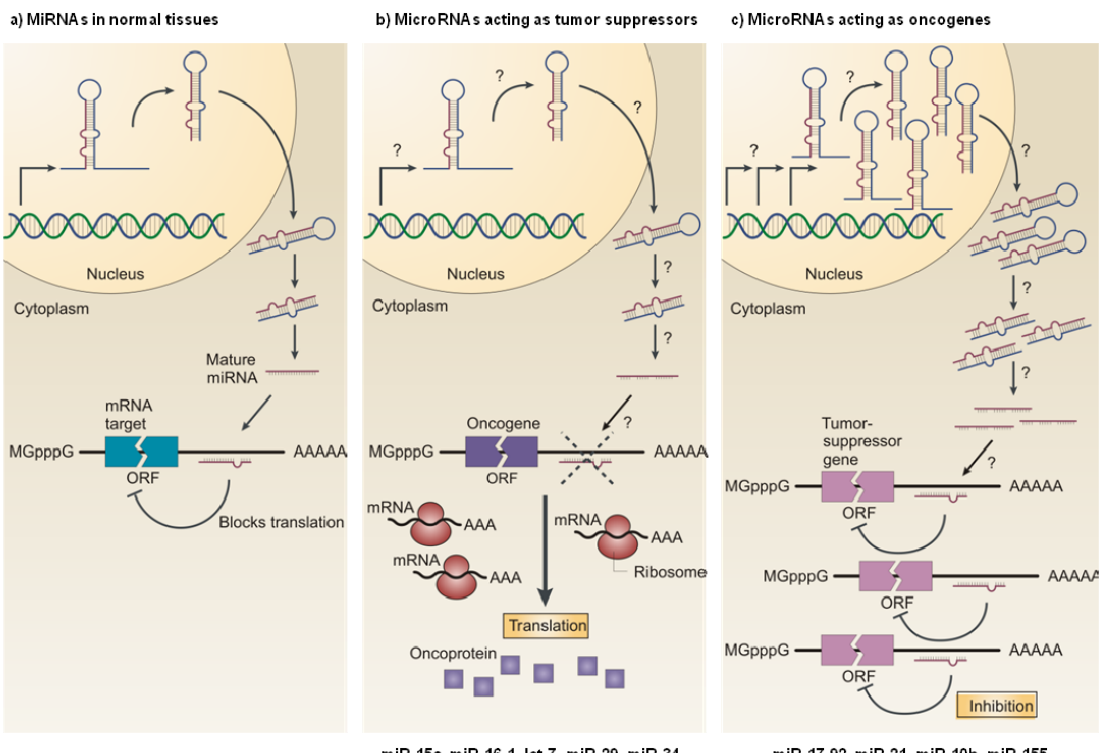
Figure 1. MicroRNAs as tumor suppressors and oncogenes. ( a ) In normal cells, miRNA transcription, processing and binding to complementary sequences in the target mRNA lead to the repression of their target genes, by either mRNA translation inhibition or mRNA degradation. ( b ) The reduced expression of a miRNA that acts as a tumor suppressor, as a result of chromosomal deletion or defects at any stage of miRNA biogenesis (indicated by question marks) leads to the increased synthesis of the miRNA-target oncoprotein (purple squares), and ultimately to the development of an oncogenic phenotype. ( c ) The increased expression of a miRNA that acts as an oncogene, as a result of (among others) amplification of the miRNA gene or constitutive promoter activation (indicated by question marks), leads to the repression of a miRNA-target tumor-suppressor gene (pink), which favors the development of an oncogenic phenotype. ORF: open reading frame; mGpppG: 7-methylguanosine. Reproduced with permission from